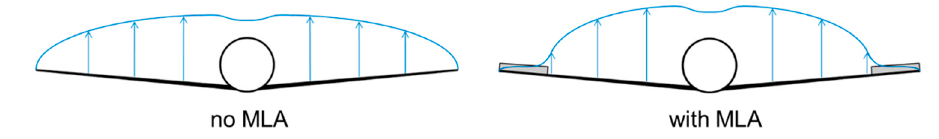
Figure 12. Change of spanwise lift distribution with MLA.